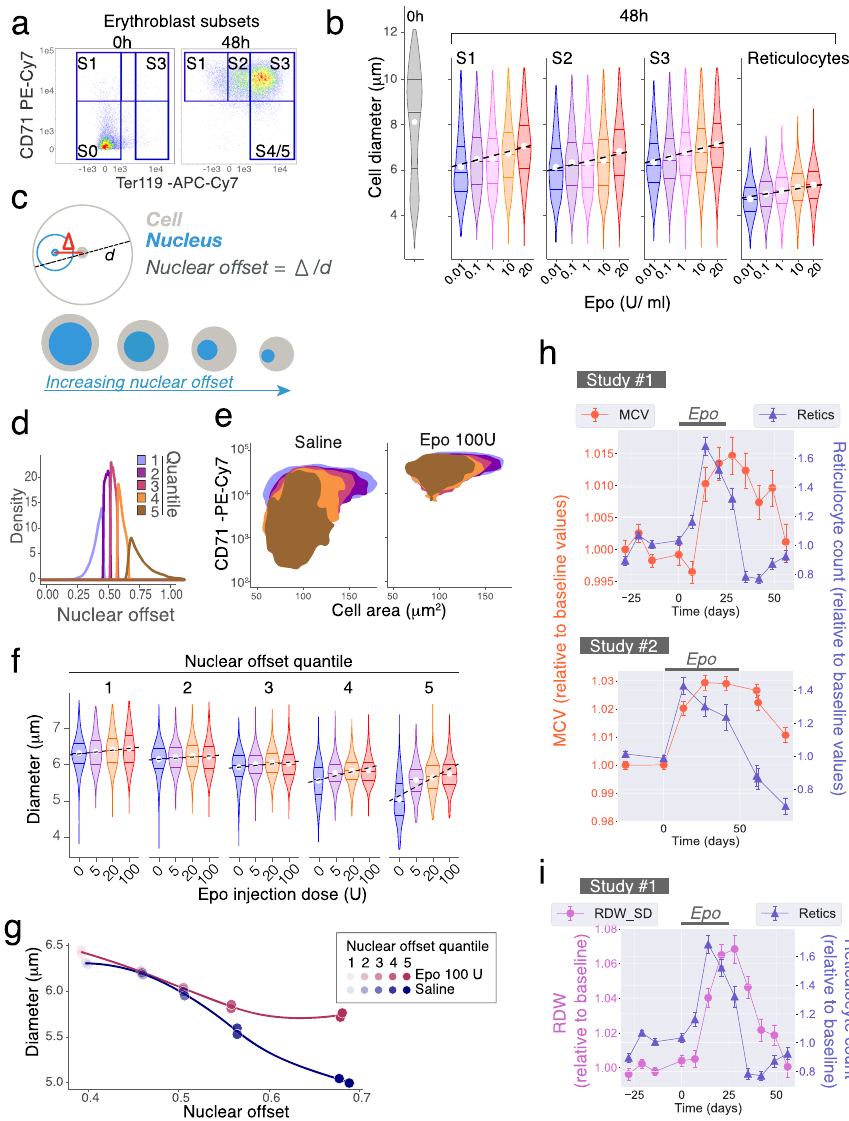
Fig. 6 Red-cell size regulated by Epo concentration in mice and humans. a , b Epo regulates erythroblast diameter. CFU-e progenitors ( ‘ S0 ’ ) enriched from wild-type fetal livers were differentiated in vitro in a range of Epo concentrations and analyzed at 48 h. Representative of two independent experiments. a S0 cells differentiate into the S1, S2, and S3 subsets by 48 h. b Cell diameter distributions for each erythroblast subset and Epo concentration. Violin lines are 25th, 50th, and 75th percentile. White circles mark the mean. c Nuclear offset measures nuclear eccentricity, independently of cell size. It is the ratio of the delta centroid (distance between the centers of the cell and the nucleus, Δ ) and cell diameter. Nuclear offset increases during erythroid morphological maturation. d – g Mice were injected with saline ( n = 2) or Epo ( n = 2 mice with either 5 U, 20 U, or 100 U). Bone marrow analyzed at 48 h. d Nuclear offset quintiles for Ter119 + erythroblasts in saline-injected mice. e CD71/forward-scatter (FSC) histograms for the nuclear offset quintiles in ( d ) of Ter119 + erythroblasts. Quintile values that were determined for saline-injected mice were also applied to the Epo-injected mice. Sequential quintiles are seen to contain increasingly mature erythroblasts. f Cell diameter in each nuclear offset quintile in ( e ), for each Epo dose. Violin lines are 25th, 50th, and 75th percentile, white circle marks the mean. Data representative of n = 2 mice per Epo dose. g Median cell diameter and median nuclear offset values in each nuclear offset quintile, for mice injected with Epo (100 U) or Saline. Datapoints are individual mice. h Human intervention studies. Epo was administered during the period indicated. In study #1, n = 25 subjects were treated with Epo and n = 9 subjects with placebo. In study #2, n = 24 each for placebo and Epo. Data is fractional change relative to the baseline values of each participant. Additional hematological parameters and data for placebo groups are in Supplementary Figs. 14, 15 and Supplementary statistical analysis. MCV, mean corpuscular volume; Retics, reticulocyte count. i RDW_SD and reticulocyte counts for human intervention study #1 described in panel ( h of these pathways in the regulation of cell size. PI3K inhibition pathways: ras/MAP kinase, Stat5 39,66 , and PI3K 67,68 . Neonatal mice signi fi cantly decreased the size of early ( ‘ S2 ’ ) and late ( ‘ S3') ery- hypomorphic for Stat5 have microcytic anemia 69 . Here we found throblasts and reticulocytes, but MEK1/2 inhibition had no con- that, similarly, circulating red cells from E13.5 Stat5 -de fi cient sistently signi fi cant effect (Supplementary Fig. 13c, d). Therefore, it embryos are smaller than those of wild-type littermates (Supple- is likely that cell size regulation by EpoR is the integrated result of mentary Fig. 13a, b). Using U0126, a MEK1- and MEK2-speci fi c multiple signaling pathways. inhibitor 70 , and the PI3K inhibitor LY294002, we examined the role